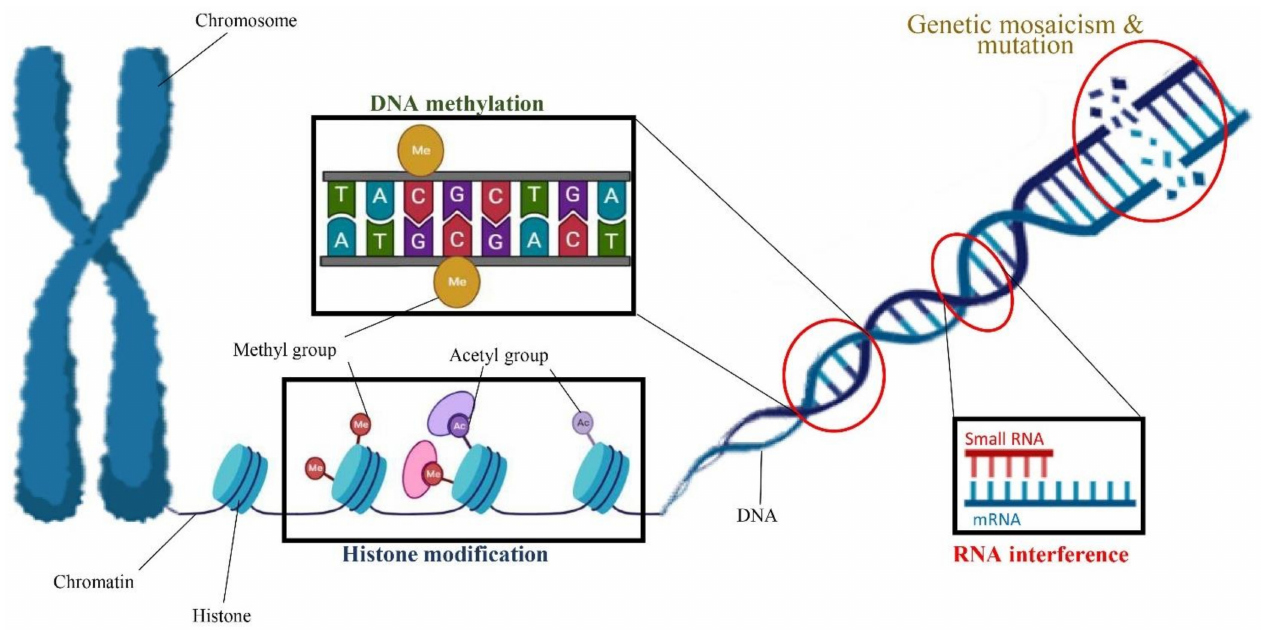
Figure 4. A schematic view of factors involved in somaclonal variation including genetic mosaicism and mutation as well as epigenetic regulations such as DNA methylation, histone modification, and RNA